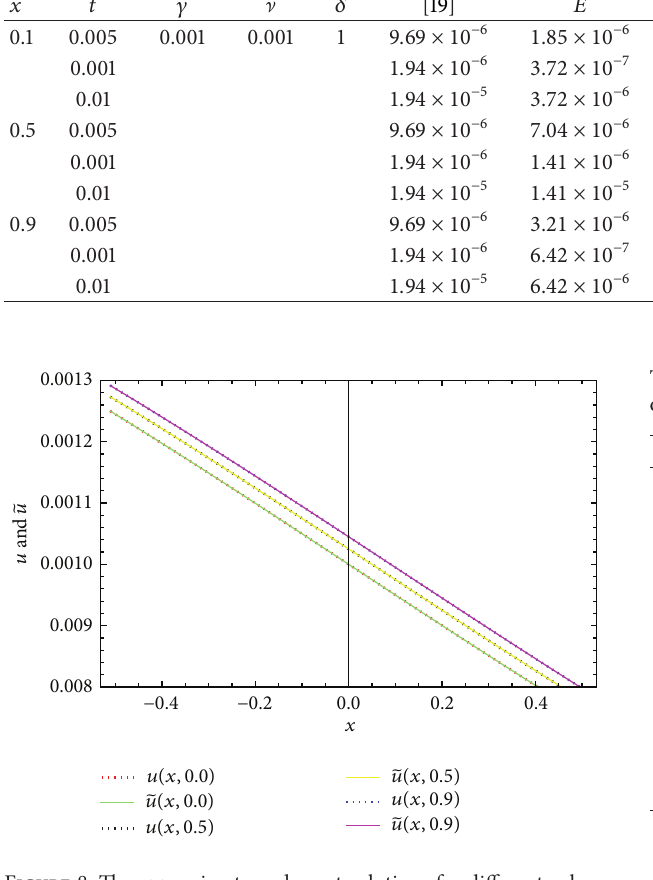
Figure 8: The approximate and exact solutions for different values of 𝑡 (0, 0.5 and 0.9) of problem (40) where ] = 10 , 𝜇 = 0.1 , 𝑐 = 0.1 , 𝛼 = 𝛽 = −0.5 , and 𝑁 = 20 .